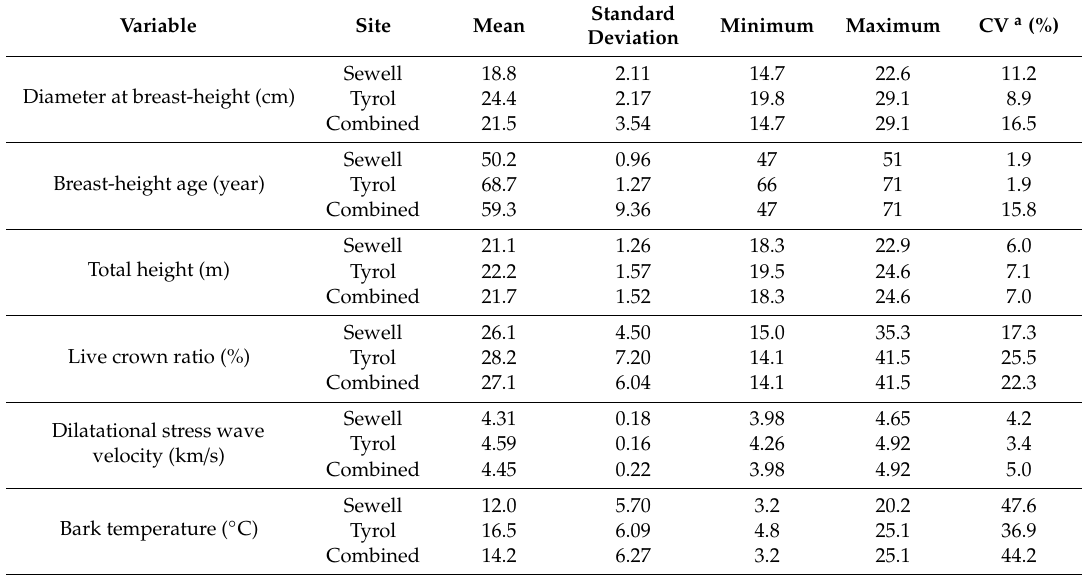
Table 1. Descriptive statistical summary of the mensurational characteristics and acoustic velocity measurements of the 61 sample trees by site ( n = 31 and 30 for Sewell and Tyrol, respectively).